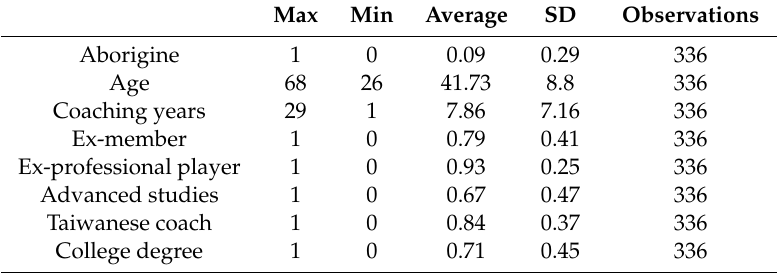
Table 6. Descriptive statistics of the input-output indicators of the integration performance of CPBL teams.